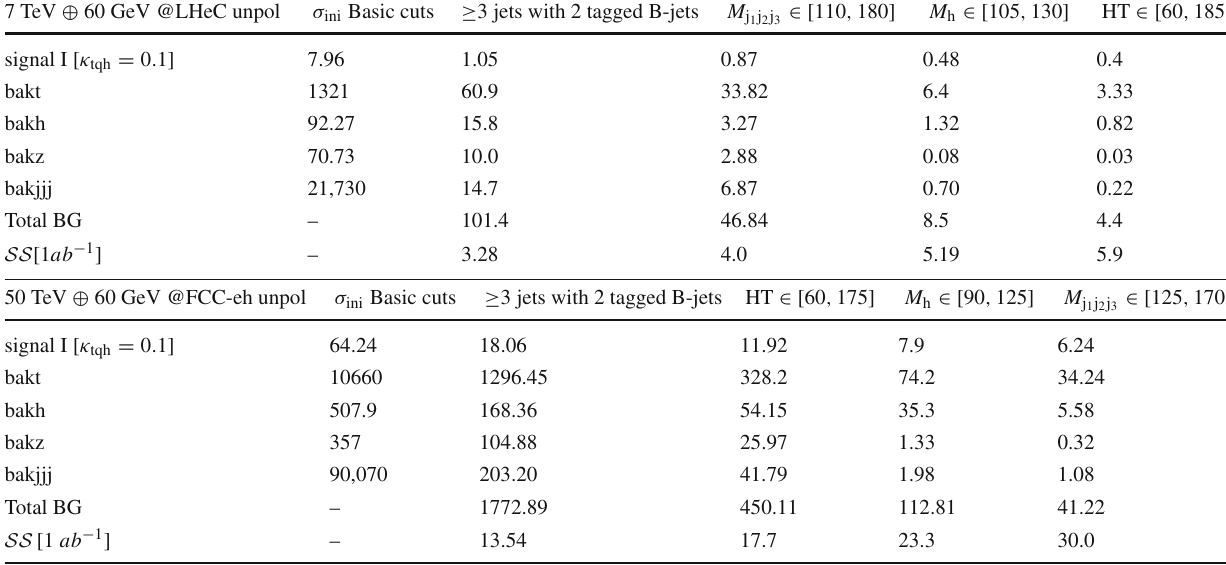
Table 1 Cross sections (in units of fb) and significance depending on the cut flows for signal I e − p → ν e ¯ t → ν e h ¯ q → ν e b ¯ b ¯ q ( κ tuh = 0 . 1) and backgrounds at the 7 TeV ⊕ 60 GeV @LHeC and 50 TeV ⊕ 60